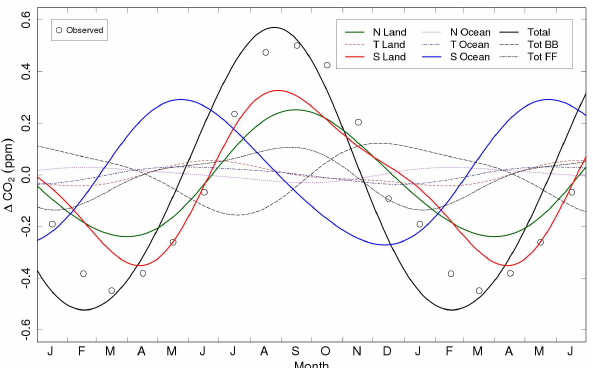
Fig. 7. (a) Seasonal CO 2 cycle components from STL decompo- sition of Baring Head and South Pole records. Fits used a 5-year smoothing window on Loess fits to individual monthly time series. The BHD line is the same as that shown in Fig. 4c. (b) Seasonal CO 2 cycle peak-to-peak amplitudes from curves in (a) . The fits in- clude data prior to December 1972 from the Makara